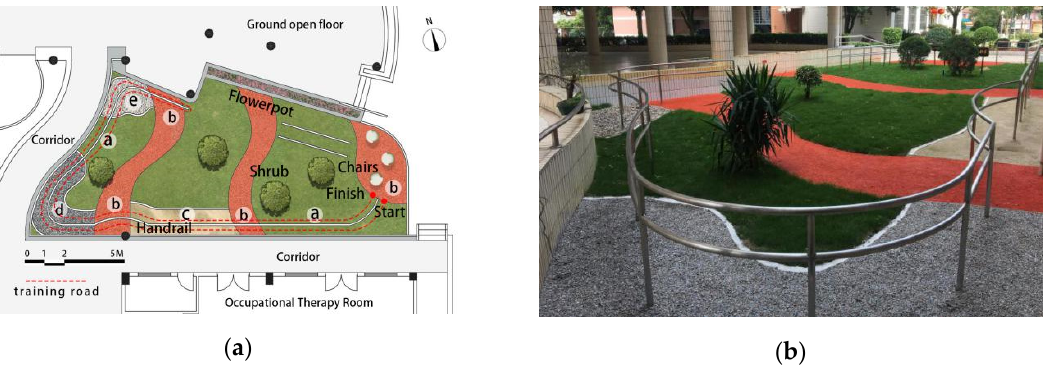
Figure 1. ( a ) The layout of the outdoor multisurface terrain: ⓐ grassland (19.6 m), ⓑ plastic cement (11 m), ⓒ sand (12.3 m), ⓓ gravel (14.7 m), ⓔ unfixed pebbles (6.9 m). ( b ) A perspective view of the outdoor multisurface terrain.